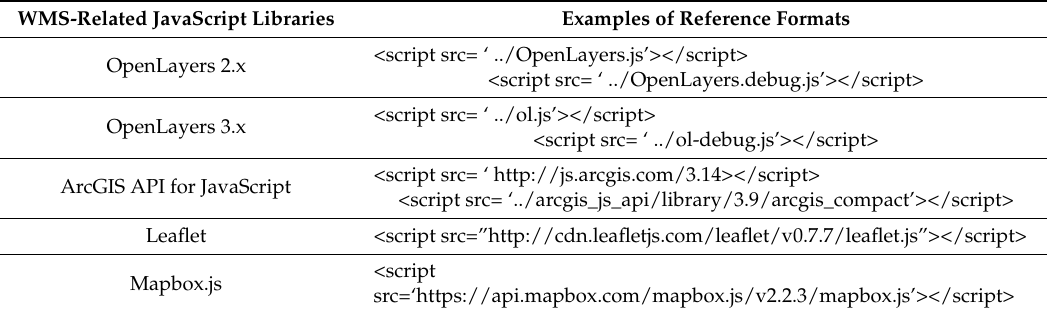
Table 1. Reference formats of the four WMS-related JavaScript